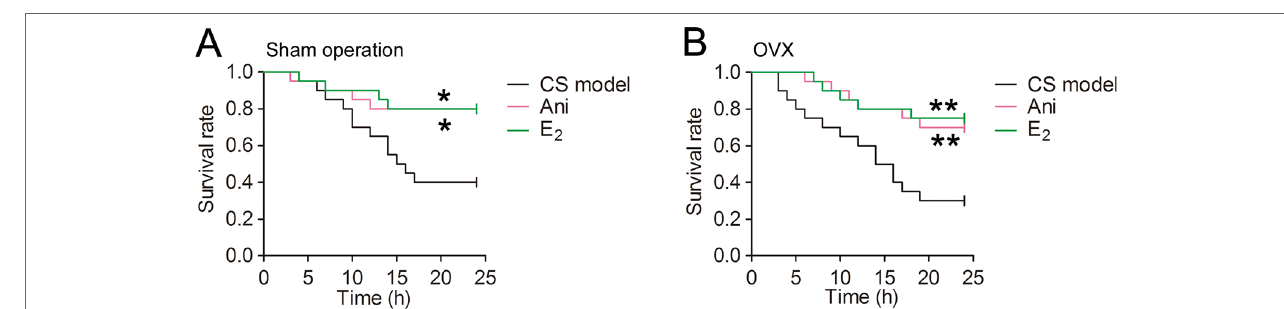
FIgURE 4 | Anisodamine (Ani) and E 2 decreases mortality in mice with crush syndrome (CS). Ani (28 mg/kg, i.p.) or E 2 (100 mg/kg, i.p.) was administrated at 30 min before decompression in mice with CS 2 weeks after ovariectomy (OVX) surgery or its sham operation. Both Ani and E 2 prolonged survival time in mice with CS received OVX surgery (B) or its sham operation (A) . N = 20 per group. * P < 0.05, ** P < 0.01 vs. CS